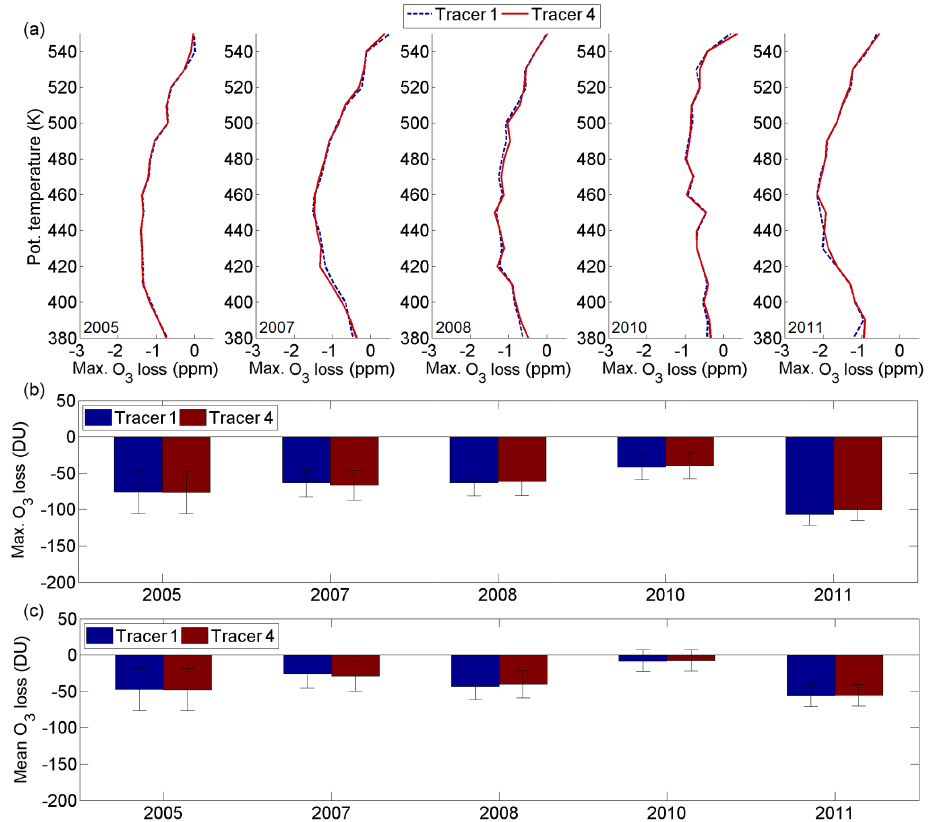
Figure 8. Similar to Fig. 6, but for the artificial tracer correlation method. Tracer 1 (N 2 O, CH 4 , CCl 2 F 2 , and CCl 3 F) in dark blue and Tracer 4 (N 2 O, CH 4 , OCS, and CCl 3 F) in dark red. Details about the composition of the four tracers are provided in the